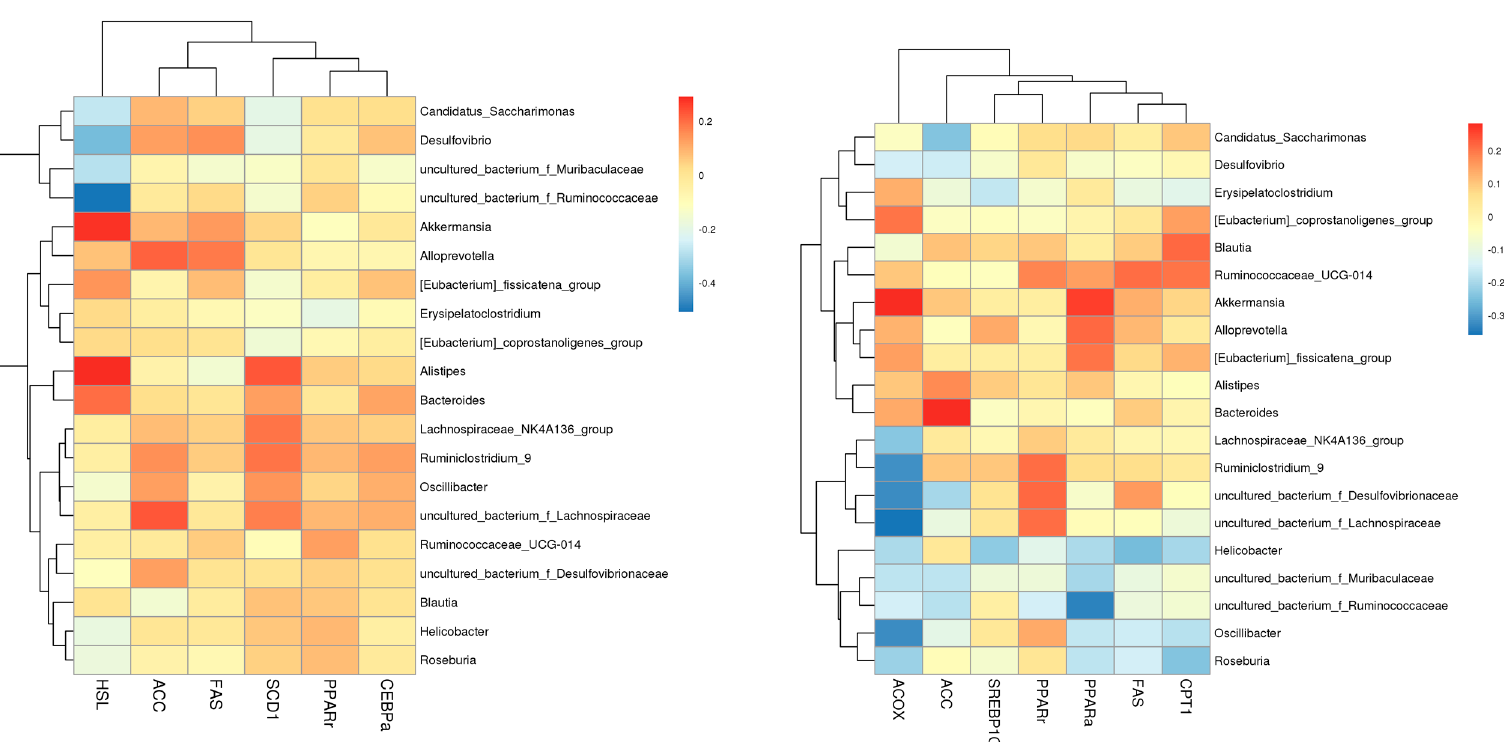
Figure 5. Spearman’s correlation between the metabolic genes and the relative abundance top 20 bacteria at the genus level ( A ) metabolic genes in the adipose tissue; ( B ) metabolic genes in liver tissue. The different colors of bar represented the degree of association (red, positive correlation; blue, negative correlation).